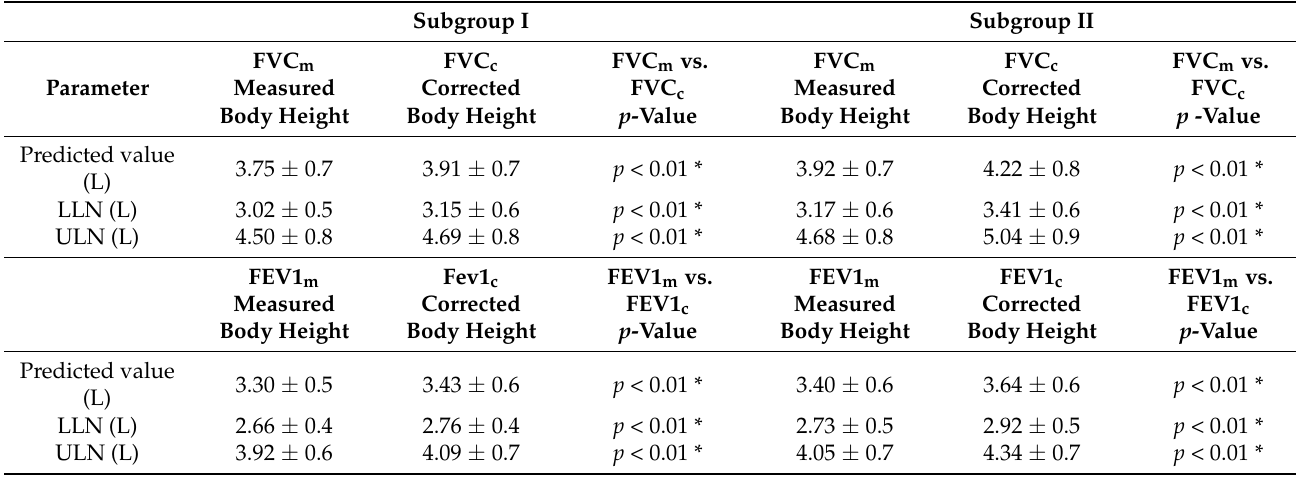
Table A3. Comparison of the predicted values of the pulmonary parameters calculated (GLI 2012, [17]) for the measured versus the corrected body height in subgroup I, N = 30, and subgroup II, N = 17, in Lenke 3 type patients.